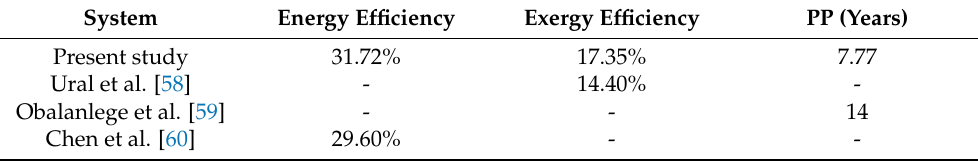
Table 6. Performance indicator comparison between the present study and relevant research.